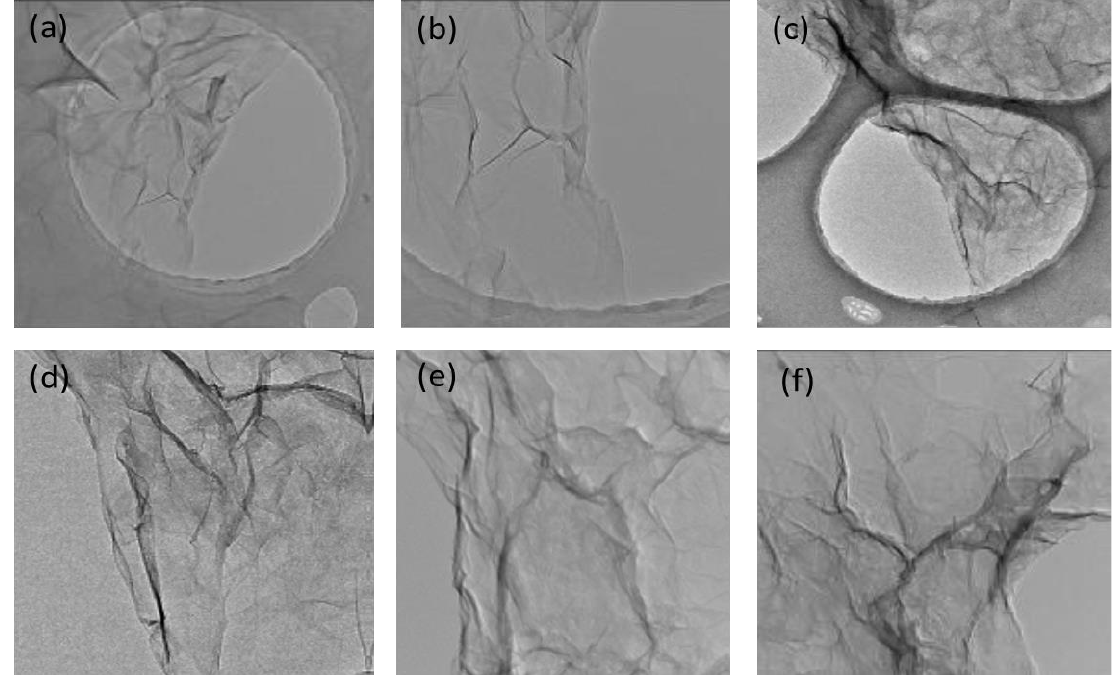
Figure 1. TEM images of hydroxyl functionalized G ( a , b ), carboxylic acid functionalized G ( c , d ), and G grafted PS ( e , f ). Taken from [58]. Reprinted with permission from Ref. [58]. Copyright 2010 American Chemical